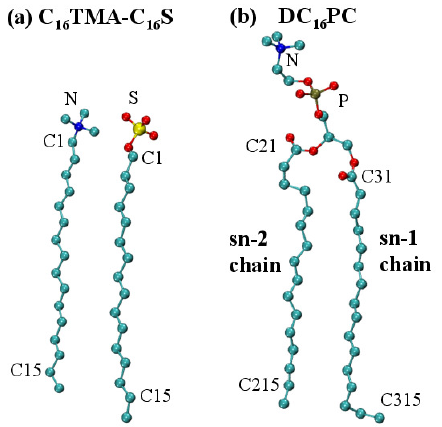
Figure 1. Molecular structures of ( a ) C 16 TMA-C 16 S IPA complex, and ( b ) DC 16 PC. The atoms utilized for data analyses are also labeled. The color codes for atoms are nitrogen in blue, sulfur in yellow, oxygen in red, and carbon in turquoise. Hydrogen atoms are not shown for clarity. Graphics were generated using VMD